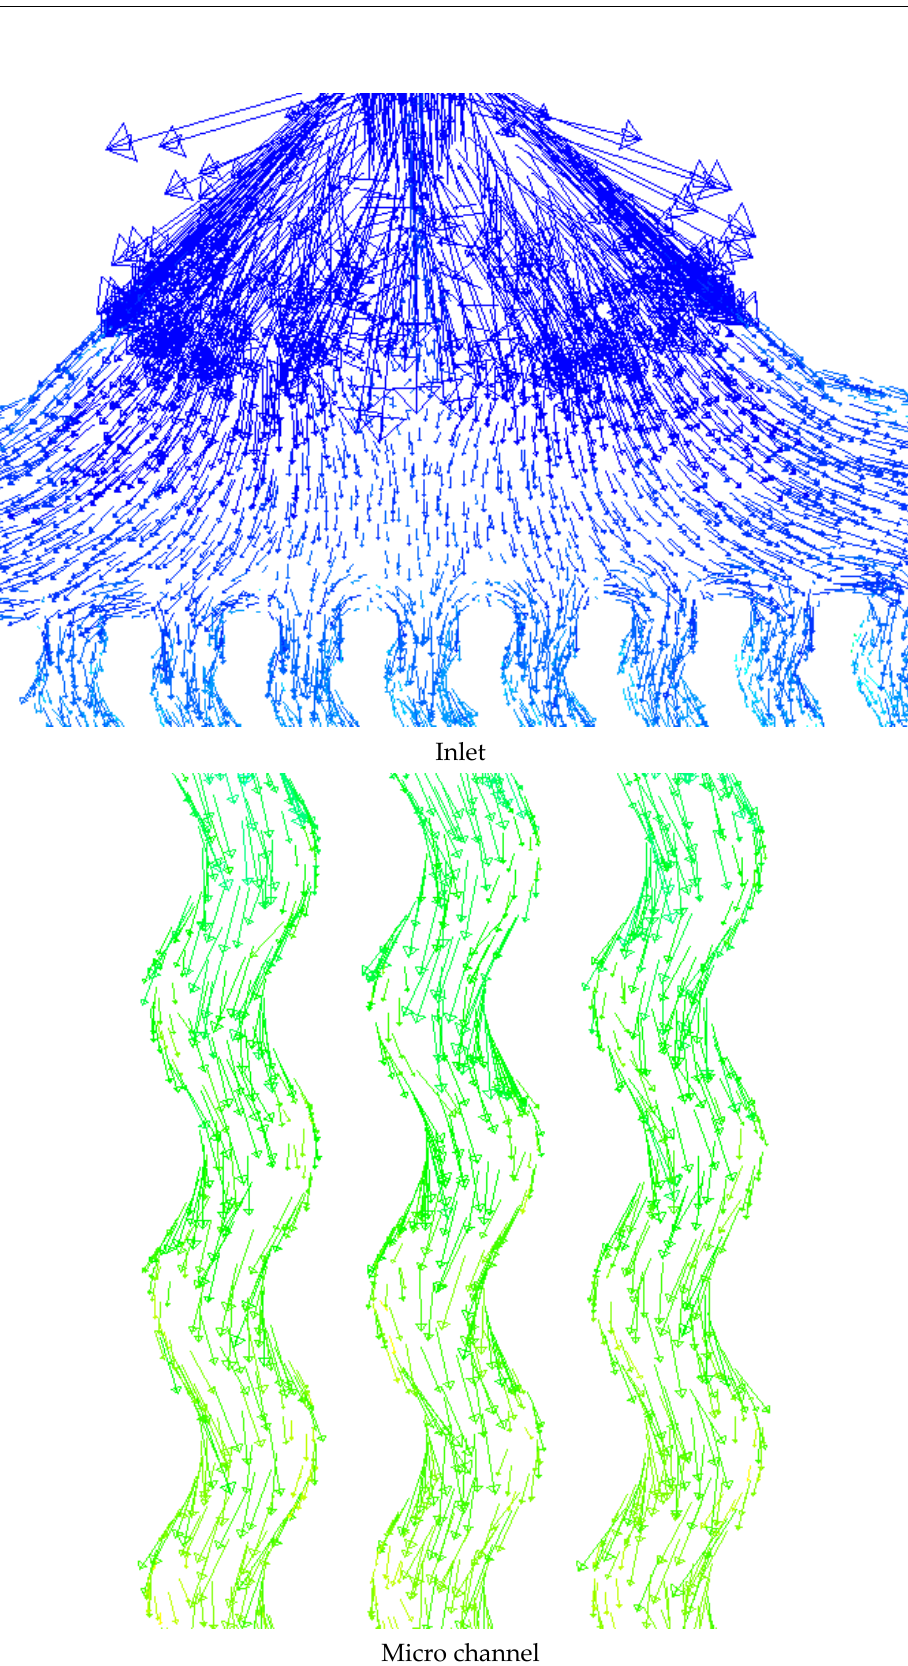
Figure 5. Velocity vectors at the fluid inlet and between the microchannels.